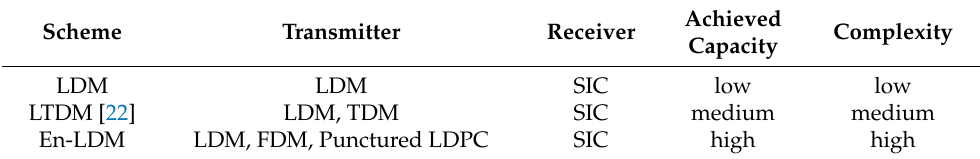
Table 1. The comparison among several layered division multiplexing (LDM)